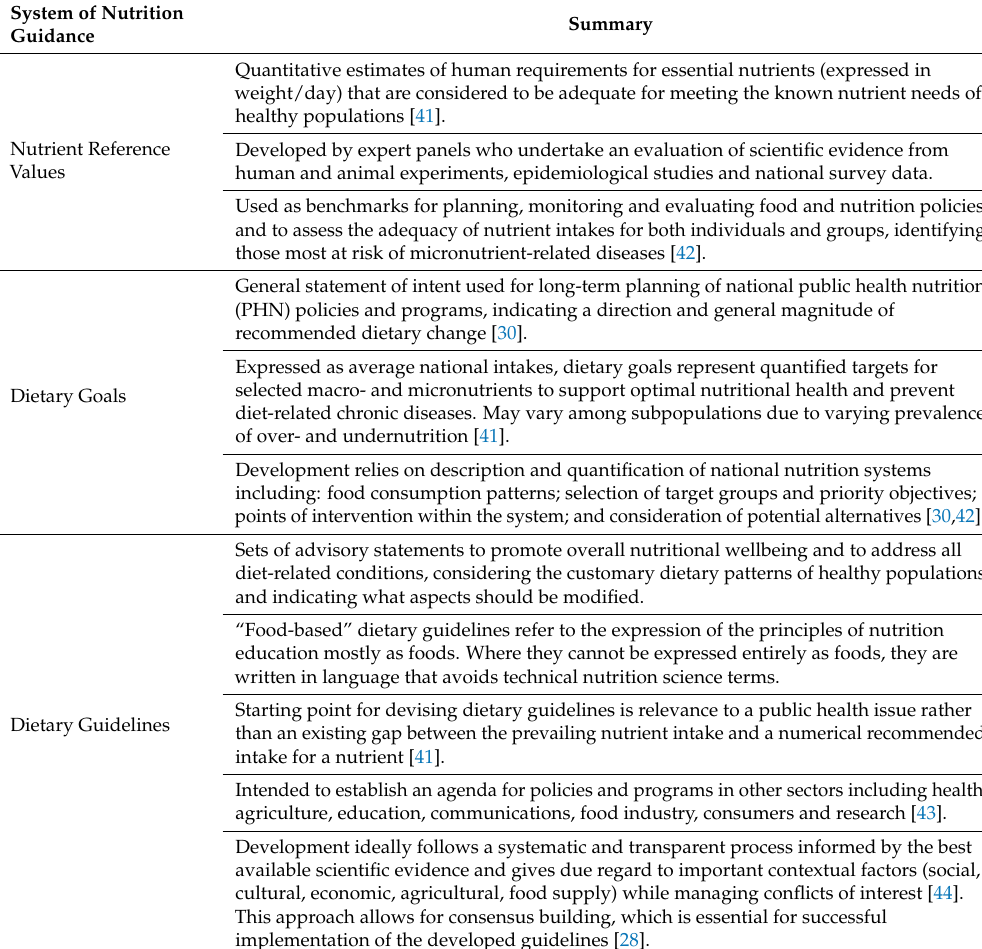
Table 3. Summary of the systems of nutrition